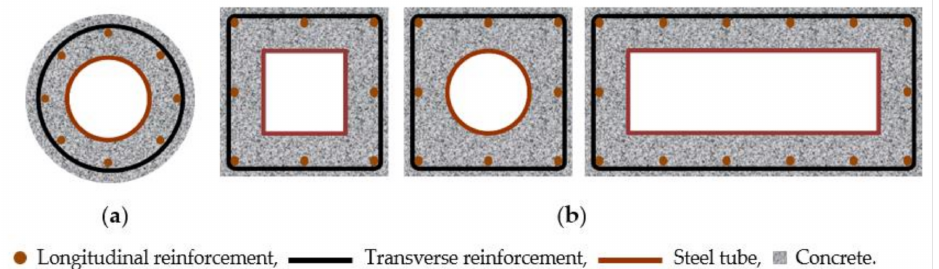
Figure 2. ICH RC structure: ( a ) circular cross-section ICH RC; ( b ) polygonal cross-section ICH